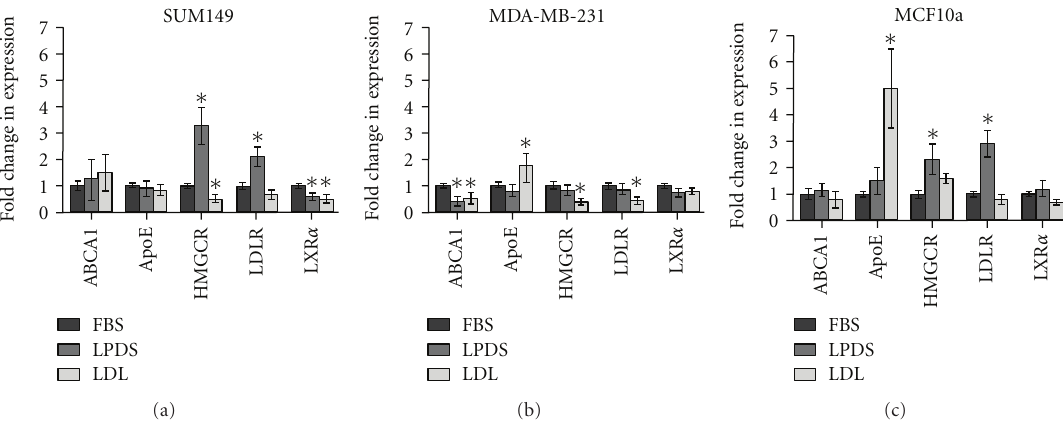
Figure 2: Relative mRNA fold change determined by QPCR analysis for SUM149, MDA-MB-231, and MCF10a cells. The fold-change for each gene is relative to FBS control mRNA levels. Statistical analysis was performed using one-way ANOVA, followed by Tukey’s HSD test ( ∗ = P < 0 . 01). The error bars represent S.E.M. All experiments were performed at least three separate times.